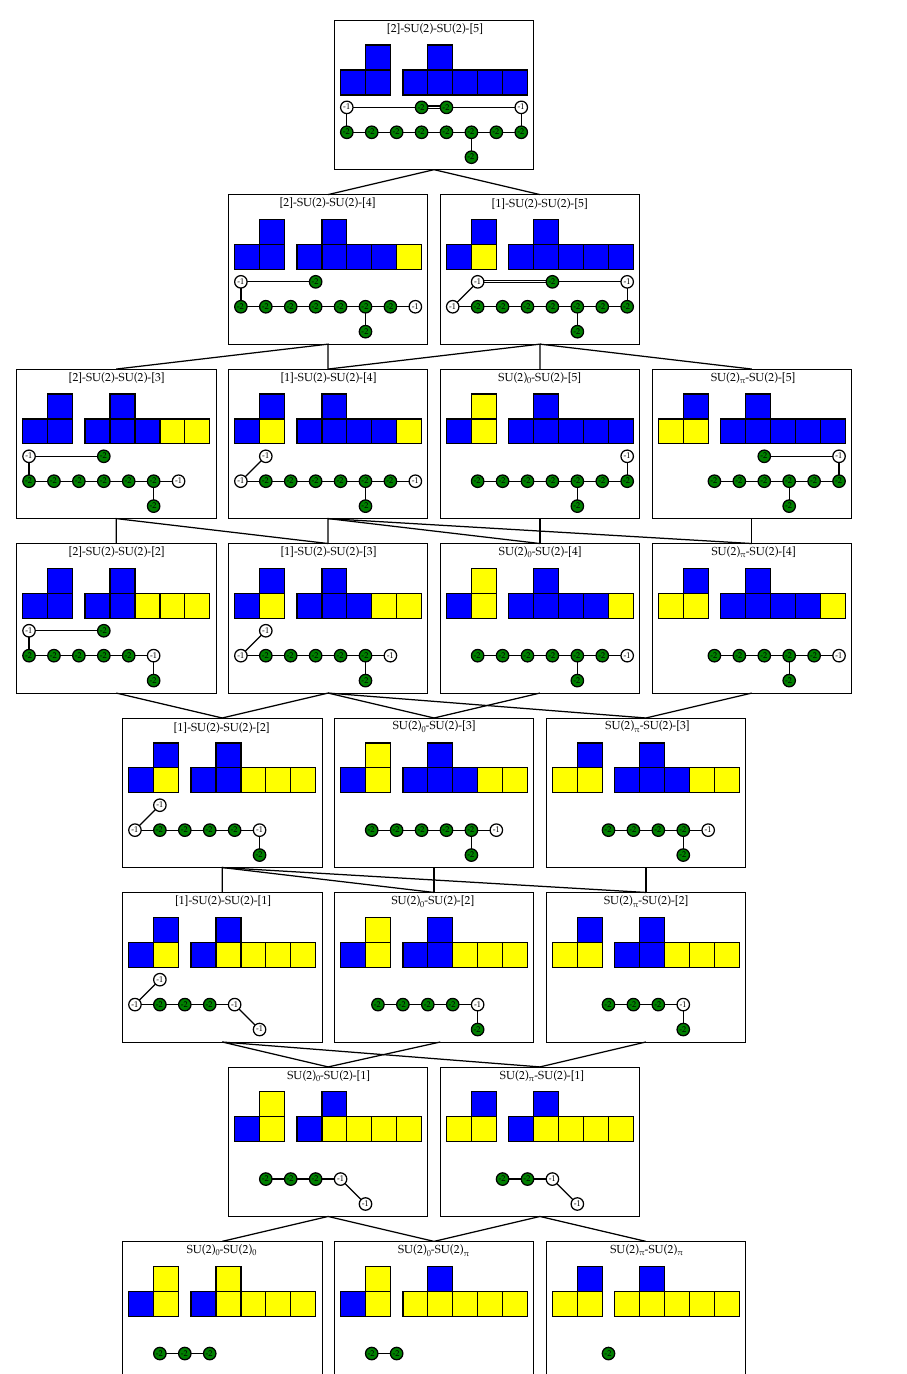
Figure 32. Rank two E-string: descendants of the marginal theory 5 F (cid:0) SU(2) (cid:0) SU(2) (cid:0) 2 F , with their (cid:13)avor-equivalence class of Coulomb phases of (SU(2) (cid:2) SU(2)) gauge (cid:2) (SO(10) (cid:2) SO(4)) BG . In addition we also note the reduced CFDs.